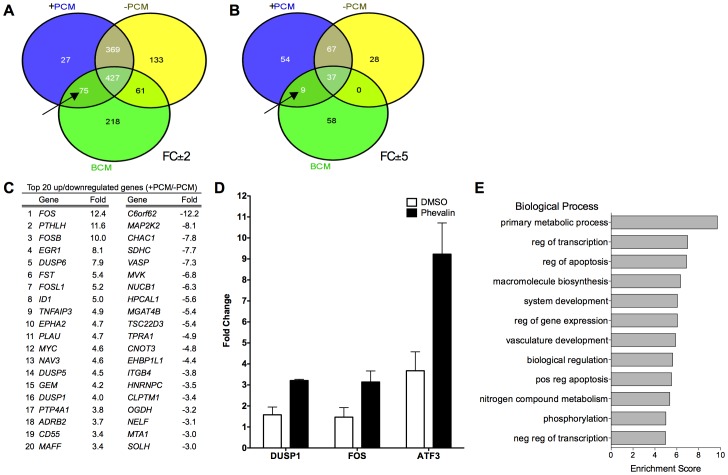
Conditioned medium from S. aureus cultures with or without additional phevalin induces differential gene expression in HKs.Significant (p<0.05) transcripts regulated ±2 fold in any one condition relative to controls. Transcripts shared between HKs treated with BCM, +PCM, and –PCM are shown at ±2 and ±5 fold change cutoffs (A and B, respectively). HKs treated with BCM shared more transcripts with +PCM treated HKs than –PCM treated HKs (arrows). Transcripts shared between –PCM and BCM had modest fold changes as no transcripts were shared above the ±5 FC cutoff. (C) The top 20 upregulated and downregulated genes (p<0.05) in +PCM treated HKs relative to –PCM treated HKs are listed. For a complete list of significantly regulated genes, see Table S1. (D) Selected genes were confirmed by RT-qPCR. The fold change relative to a GAPDH normalizer is indicated (p<0.05 for all comparing DMSO to phevalin). (E) Functional annotation clustering of microarray data revealed significantly (Benjamini p<0.01) enriched biological processes in +PCM treated HKs.